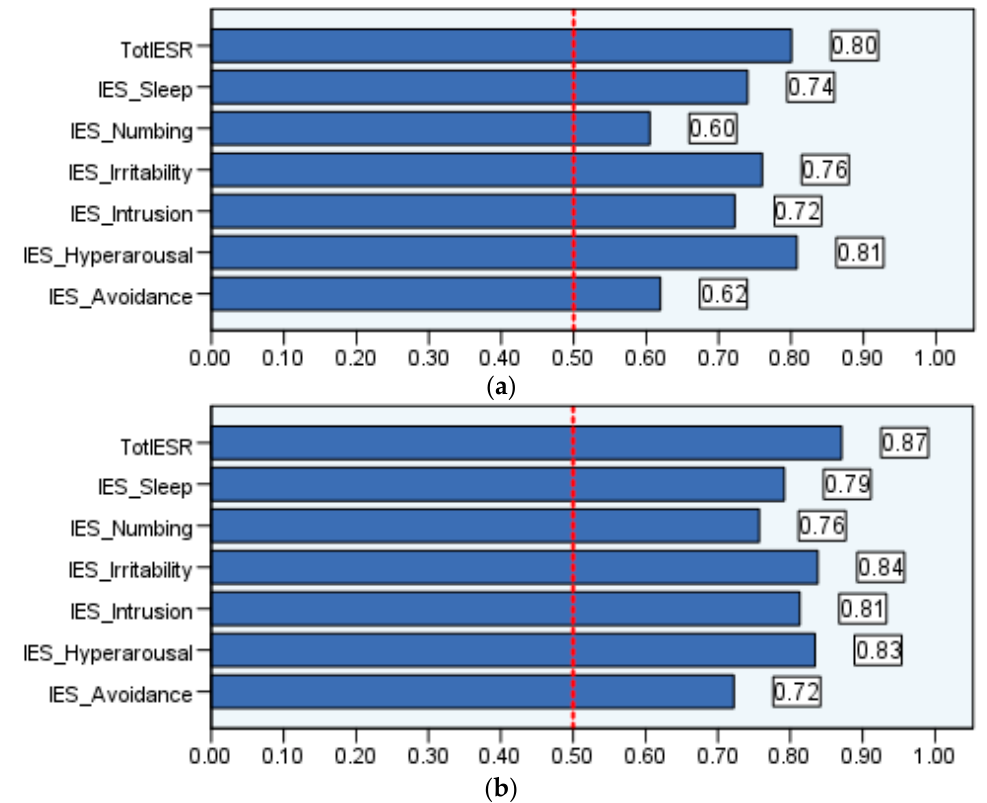
Figure 1. Receiver operating characteristic (ROC) curve using the scores of the Arabic version of the Impact of Event Scale-Revised (IES-R) and its subscales to classify people with mental disorders ( a ) and healthy adults ( b ) according to their self-reported level of distress as measured by the Depres- sion Anxiety Stress Scale 8 (DASS-8).